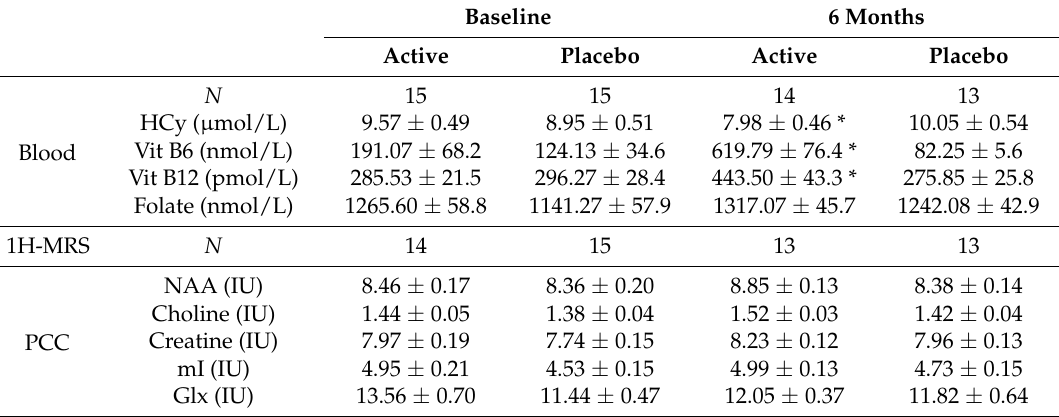
Table 4. Means (M) and standard error (SE) for blood and metabolite biomarker concentrations between